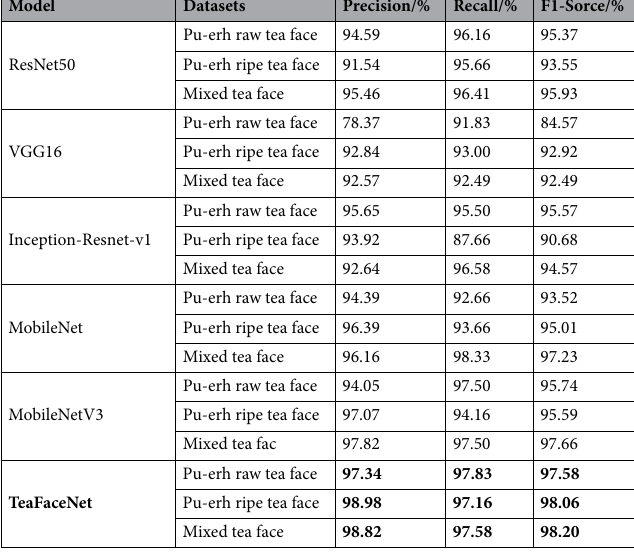
Table 8. Model performance analysis. Significant are in value